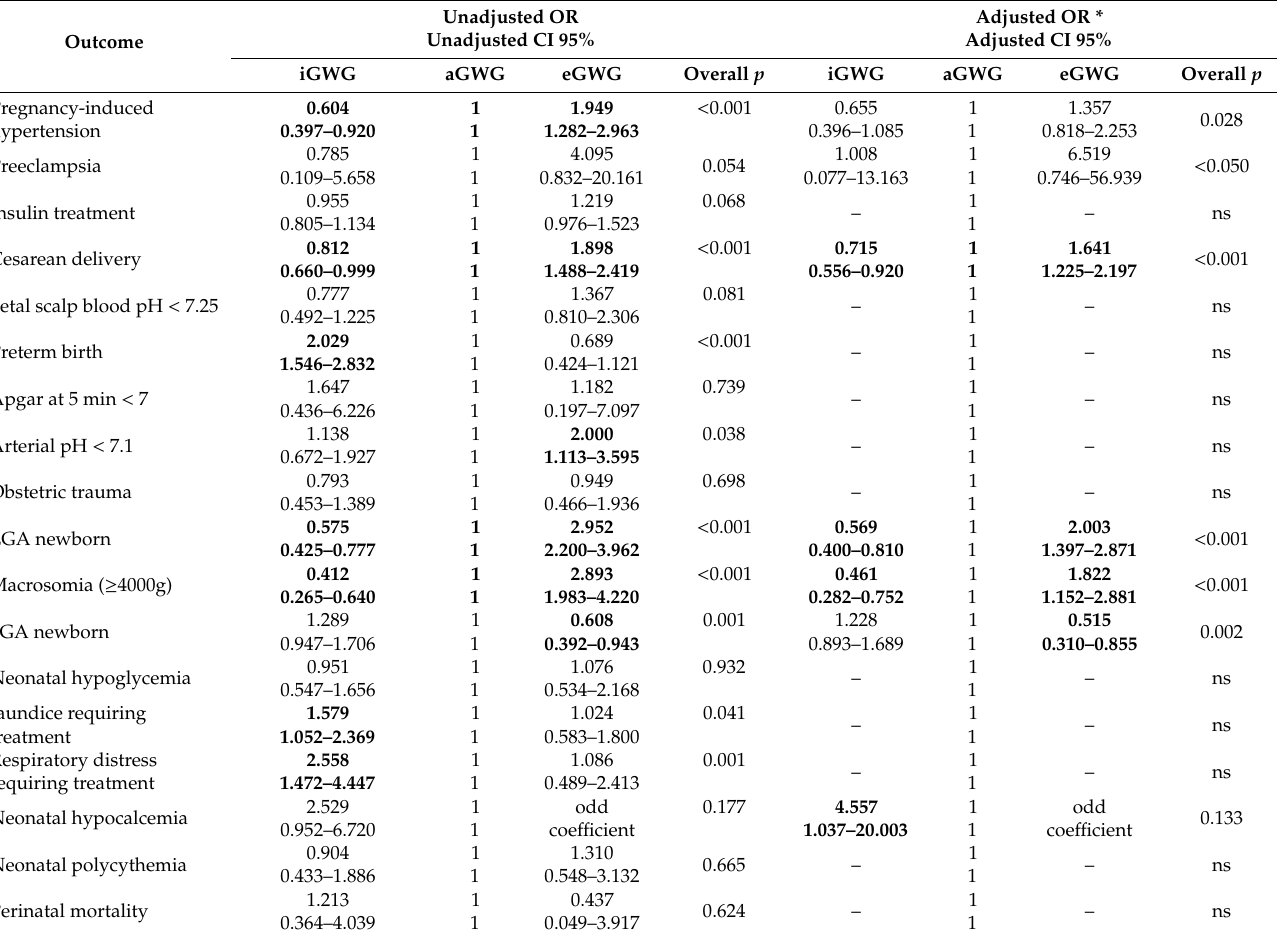
Table 4. Risk of di ff erent pregnancy outcomes in women with gestational diabetes mellitus according to gestational weight